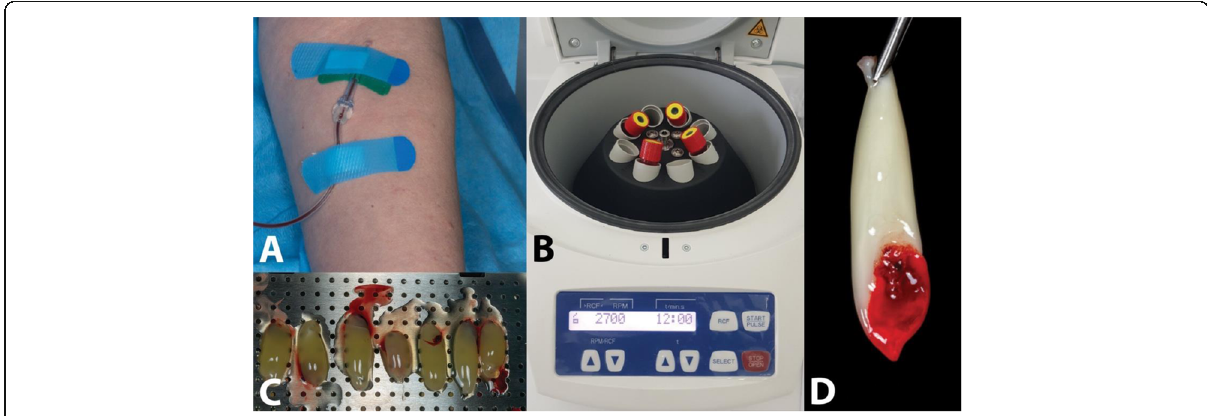
Fig. 1 PRF membrane production protocol. a Blood harvesting. b Blood centrifugation. c Clots collected from the centrifuged tubes and placed in the Xpression box kit. d Final PRF membrane